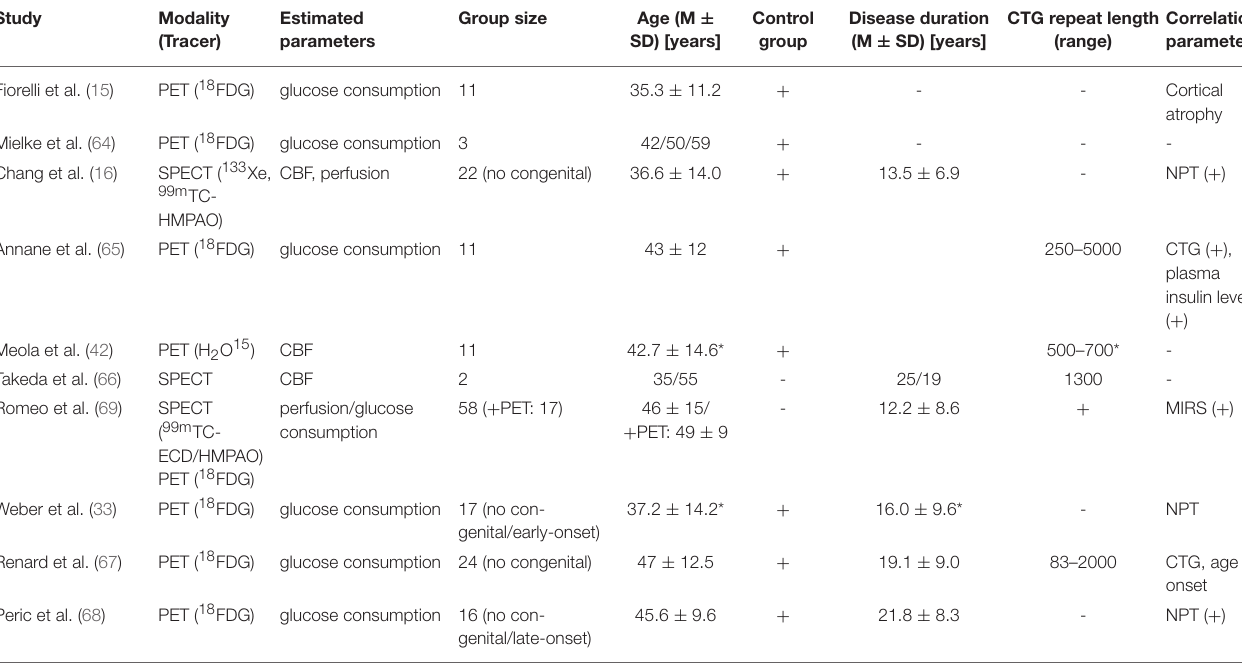
TABLE 3 | Positron emission tomography (PET) and Single photon emission computed tomography (SPECT) in DM1.